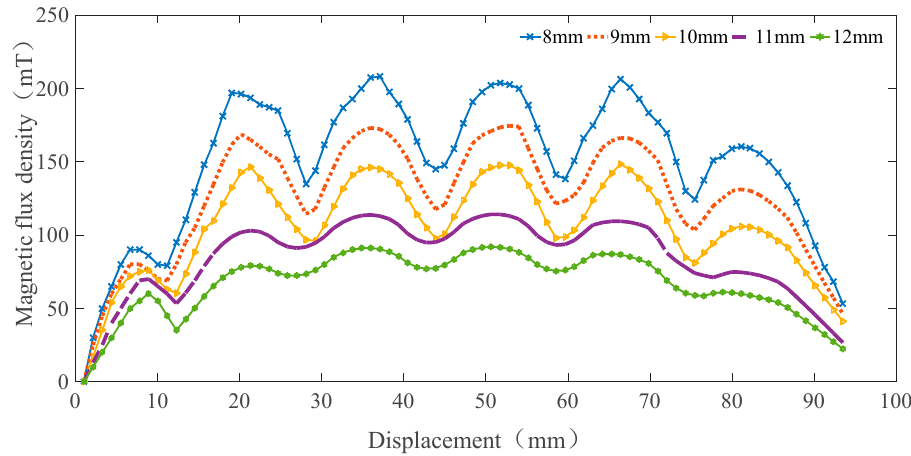
Figure 9. Effect of the air gap on the magnetic flux intensity.